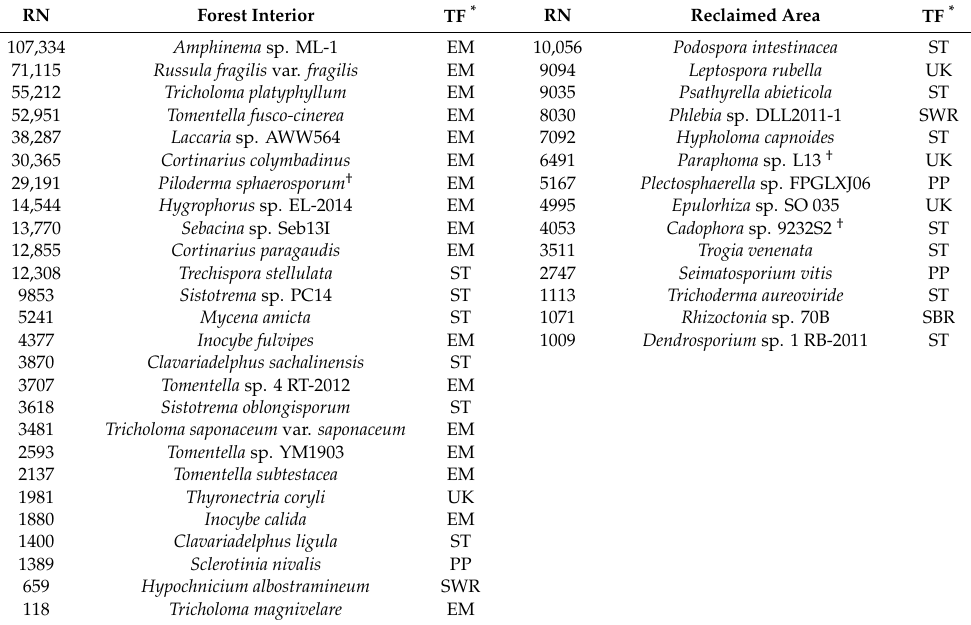
Table 3. Highly variable (defined as variance greater than 0.000,01 across samples) fungal taxa that were consistently detected more often (in terms of both relative abundance and presence / absence) in the interior of the undisturbed forest than in the reclaimed area. Taxa are ordered by total read number (RN) across all soil fractions. The trophic function (TF) associated with each taxon is listed. RN